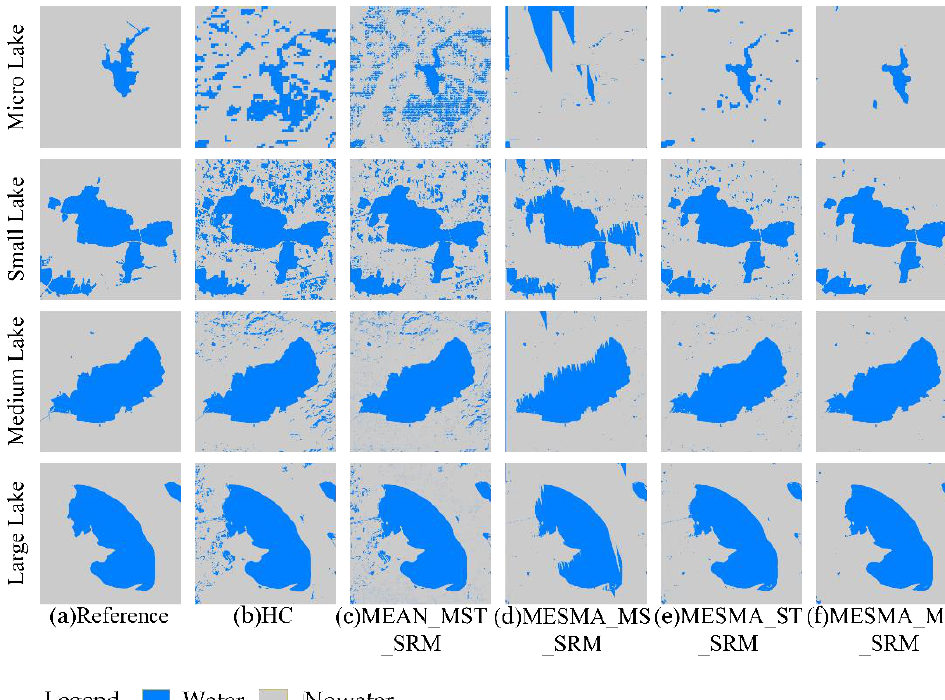
Figure 4. Comparison of resultant water body maps for different contained water bodies: ( a ) reference water body map; ( b ) water body map generated by the HC method; ( c ) water body map generated by the MEAN_MST_SRM method; ( d ) water body map generated by the MESMA_MS_SRM method; ( e ) water body map generated by the MESMA_ST_SRM method; ( f ) water body map generated by the MESMA_MST_SRM method. Table 3. Accuracy statistics comparison for different contained bodies of water such as lakes.